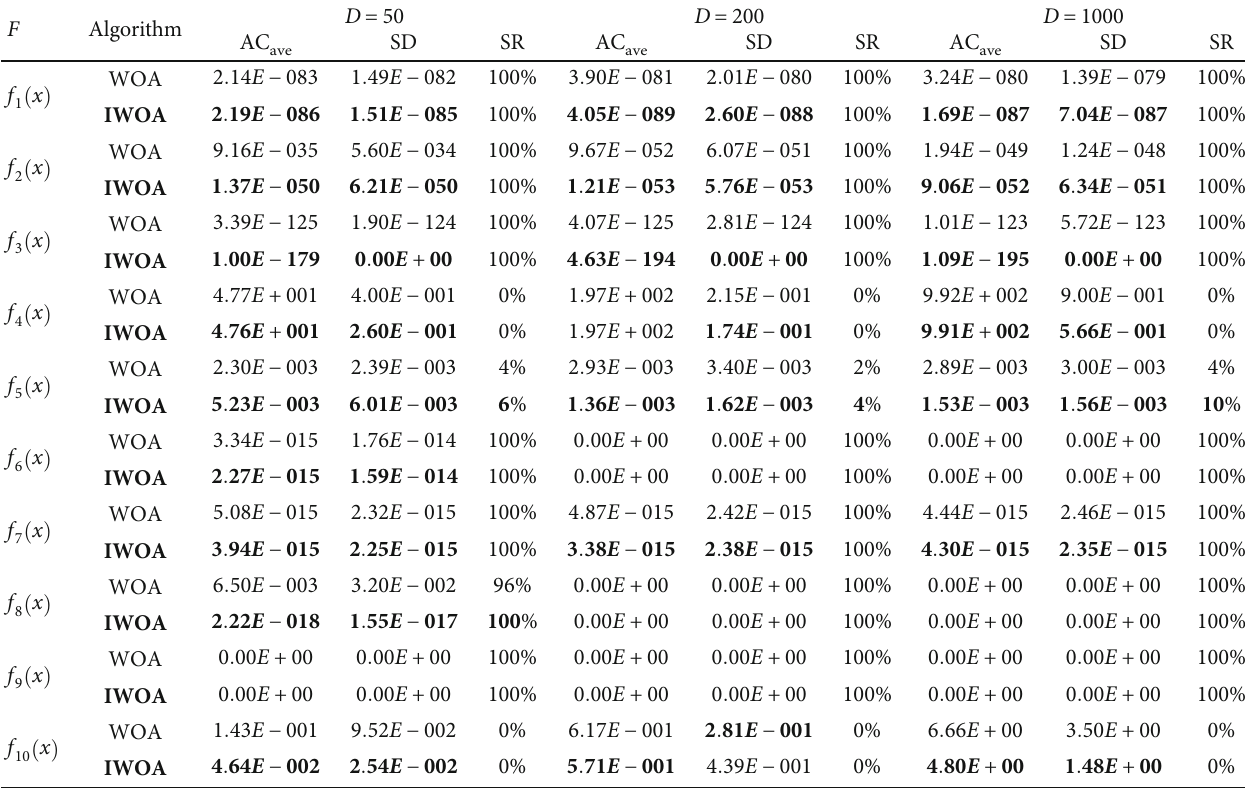
Table 7: Optimization comparison of two algorithms (classical test function).